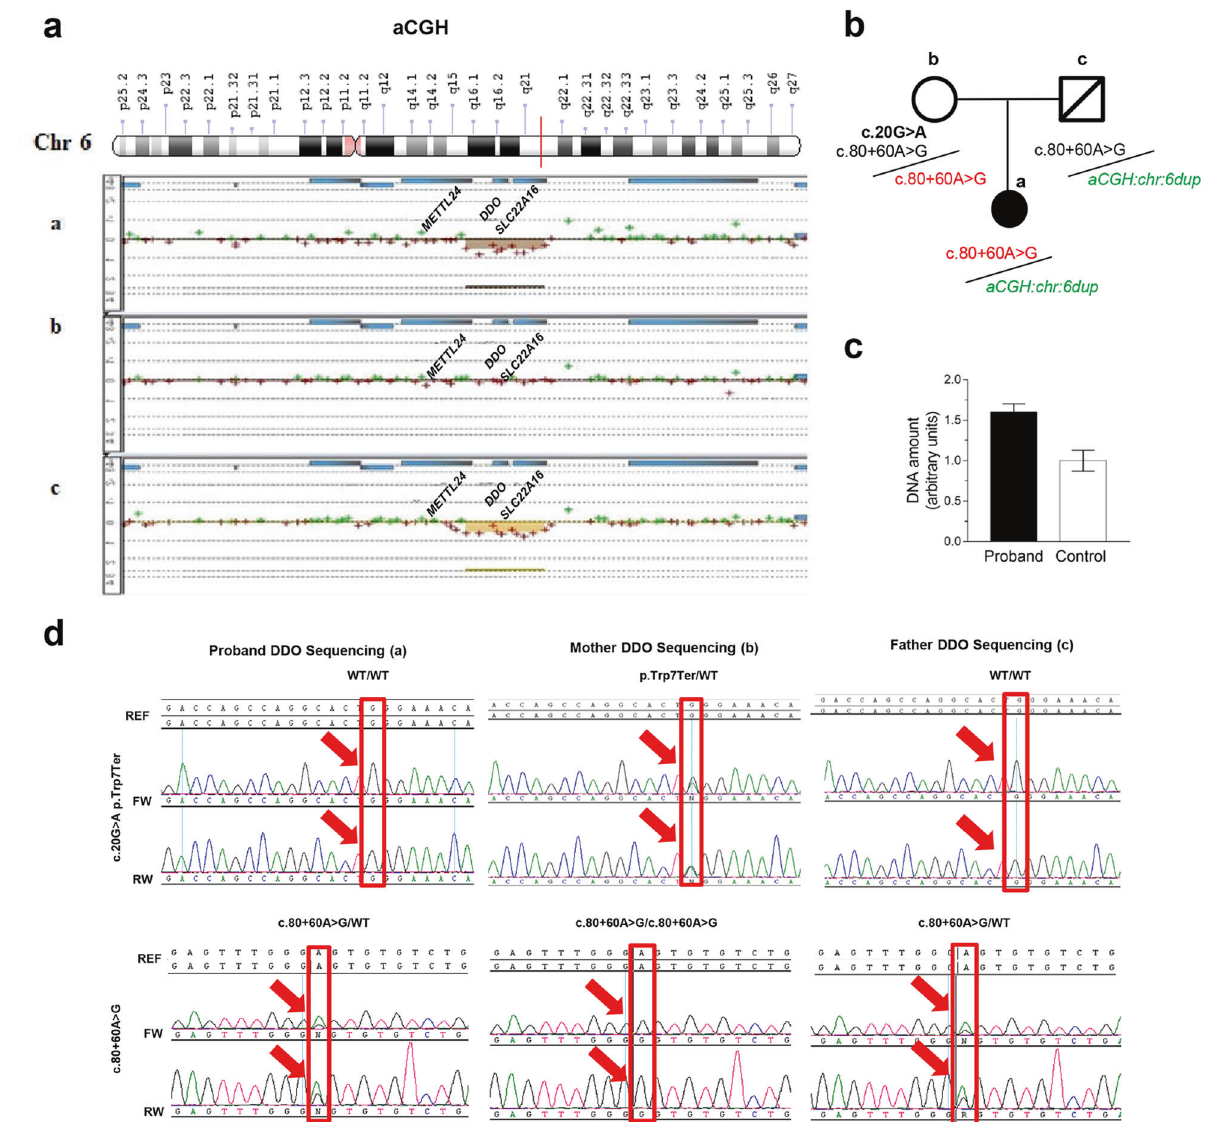
Fig. 3 Identi fi cation of DDO gene duplication and single nucleotide variants. a a-CGH pro fi le of chromosome 6 from the Agilent 4X180K array revealed duplication in 6q21 of ~128 kb involving DDO . Results are interpreted as log2 ratio of test versus control (in case of no mutation log2(2/2) = 0, in case of duplication: log2(3/2) > 0.58). The patient ( a ) exhibits a duplication inherited from her father (deceased) ( c ), absent in the mother ( b ). The green and red dots represent the log2 fl uorescence ratios of individual oligonucleotide probes on the microarrays. The red dots are indicative of the duplication segment on chromosome 6 and represent probes with positive log2 fl uorescence ratios; the green dots represent probes with negative log2 fl uorescence ratios. b Family trio pedigree reporting the DNA sequence variants identi fi ed in each family member by DDO sequencing analysis. The only variant found in the proband (c.80-60A>G) ( a ) is inherited by the mother ( b ). The mother ( b ) of the patient was found to carry a nonsense mutation (c.20G>A; p.Trp7Ter) not previously reported. c RT-PCR on proband for DDO gene. d DDO gene Sanger Sequencing electropherograms: the proband ( a ) is wild-type for the nonsense variant c.20G>A (p.Trp7Ter) as the father ( c ), the mother shows the variant in heterozygosity. The proband presents the variant c.80 + 60A>G in herozygosity as the father, while the mother is homozygous for the same variant. F forward strand, R reverse strand, REF reference sequence. The red large arrows and the rectangles indicate the exact position of each variant at sequence level. acid highly enriched in the brain before birth [15 – 17, 19 – 22] and total serine ratio, were in the range of control values (D-serine: acting as an endogenous agonist of the NMDAR [11, 14, 29] and patient, 4.78 µM — control, 3.84 ± 0.11 µM; L-serine: patient, mGluR5 [12]. Based on this evidence and on postmortem studies 354.90 µM — control, 265.40 ± 7.51 µM; D-serine/total serine ratio: indicating lower cortical levels of D-Asp and D-Asp/total Asp ratio patient, 1.33% — control, 1.43 ± 0.05%; glycine: patient, 319.43 µM — control, 280.10 ± 8.47 µM; Fig. 4f – i). in SCZ patients [29, 30], we hypothesized that D-Asp metabolism alteration might affect the normal brain development, which is known to depend on a correct NMDAR and mGluR5 activation [1]. To explore this hypothesis, we used a recently generated Ddo DISCUSSION knockin mouse model characterized by the insertion of additional The DDO gene encodes for the unique enzyme known to Ddo gene copy into the genomic locus of Rosa26 , which produces catabolize the endogenous free D-Asp [25, 62, 63], a D-amino Translational Psychiatry (2022)